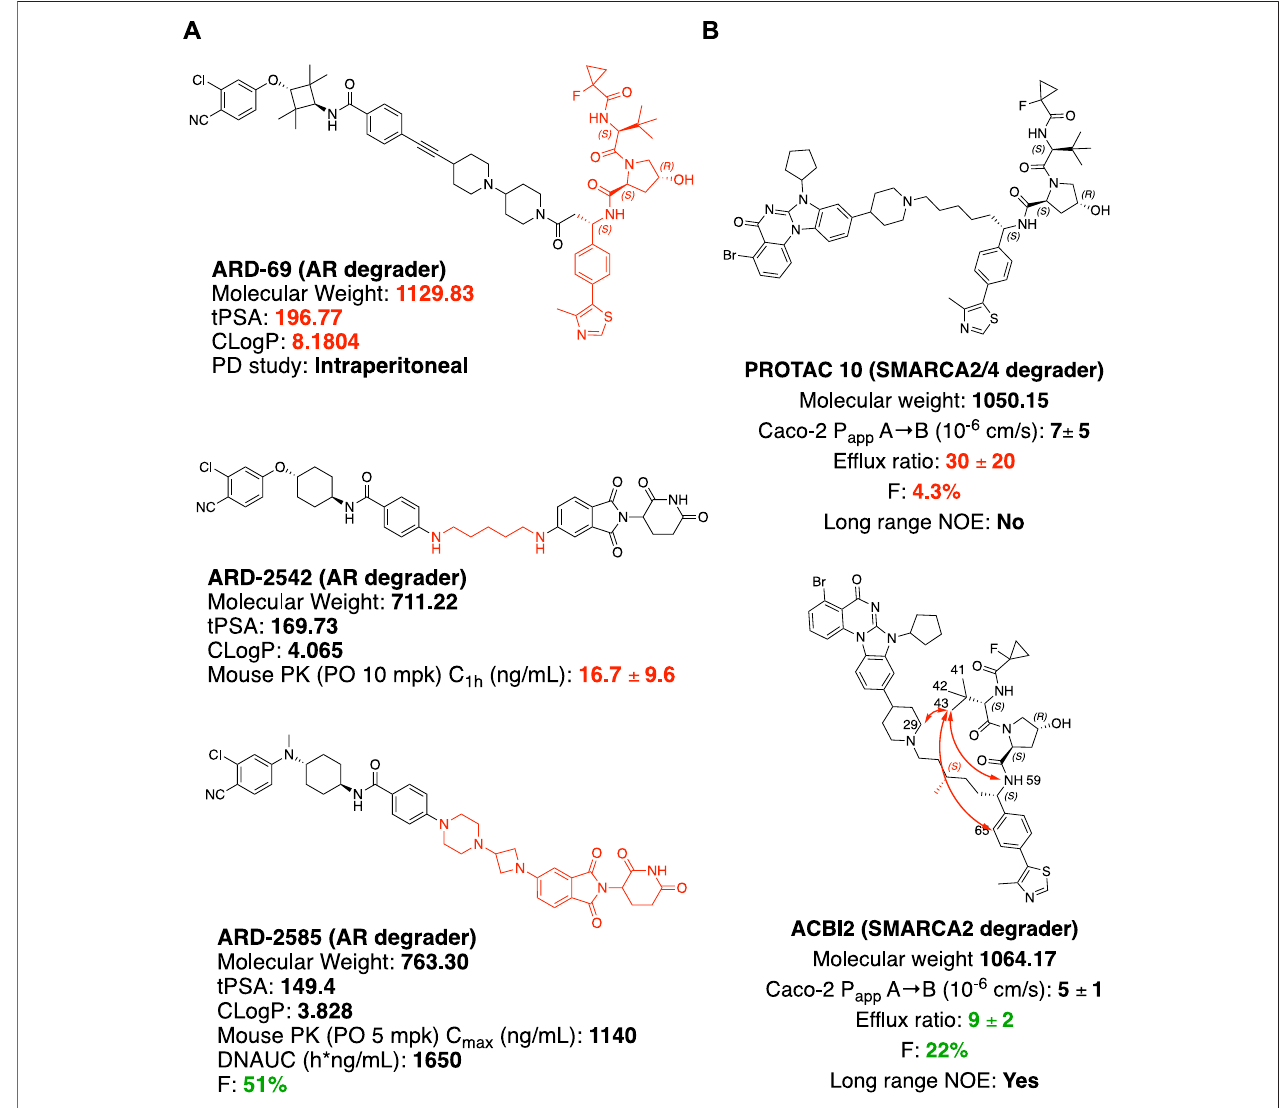
FIGURE 4 | Structure modi fi cation to improve oral bioavailability. (A) Structures of AR degraders, ARD-69 with VHL ligand, ARD-2542 with a fl exible linear linker, ARD-2585 with the rigid linker. (B) Structures of SMARCA2/4 degraders. Red arrows indicate atoms with long rang NOE.